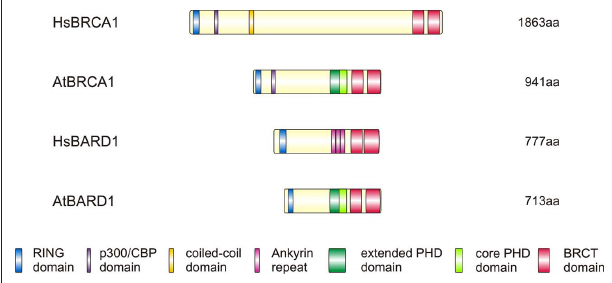
FiguRe 1 | Structural comparison of the human and Arabidopsis BRCA1 and BARD1. BRCA1 and BARD1 proteins of Homo sapiens and Arabidopsis thaliana : Despite their difference in length (1863 aa in humans and 941 aa in Arabidopsis ), these proteins have a very similar composition with common RING, P300/CBP interaction and BRCT domains. HsBRCA1 harbors a coiled-coil domain that is absent in AtBRCA1, whereas we found a larger than normal PHD in Arabidopsis BRCA1 and BARD1, but not in the human protein. BRCT, BRCA1 C-terminal; CBP, CREB binding protein; P300, histone acetyltransferase p300; PHD, plant homeodomain; RING, really interesting